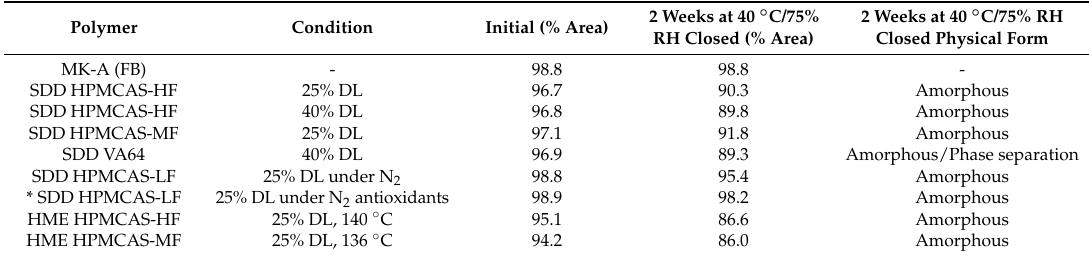
Table 4. Physical/Chemical Stability of MK-A Amorphous Solid Dispersions prepared by Spray Drying or Hot Melt